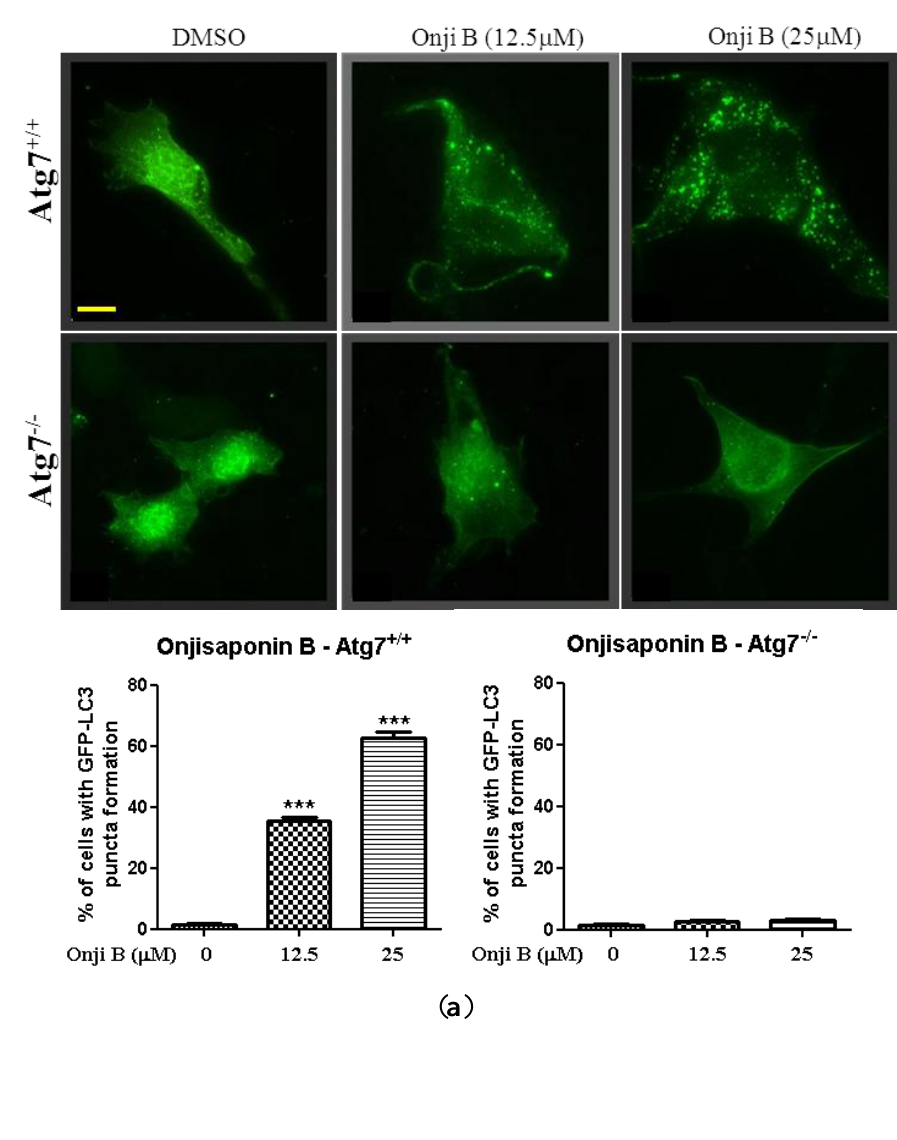
Figure 5. Onjisaponin B activates autophagy through an Atg 7, AMPK-mTOR dependent pathway. ( a ) Wild type Atg 7 and Atg 7-deficient MEFs transfected with GFP-LC3 were treated with onjisaponin B (Onji B) at the indicated concentrations for 24 h. Bottom : bar chart indicated the percentage of cells with GFP-LC3 puncta formation under these treatments; ( b ) PC-12 cells were treated with onjisaponin B at the indicated time and concentrations for 24 h. Cells treated with 0.3 μM of rapymycin (Rap) was used as a positive control. Cell lysate was then harvested and analyzed for p-AMPK, AMPK, p-p70S6K and p70S6K, respectively; ( c ) PC-12 cells expressing GFP-LC3 were treated with onjisaponin B (25 μM) in the presence of compound C (CC, 5 μM) or 3-Methyladenine (3-MA, 5 mM) for 12 h. Representative images with punctate GFP-LC3 fluorescence were captured. Bar chart indicated the percentage of cells with GFP-LC3 puncta formation under these treatments. Magnification, ×40. Columns: means of three independent experiments. Bars, S.D. *** p < 0.001. Scale bar: 15